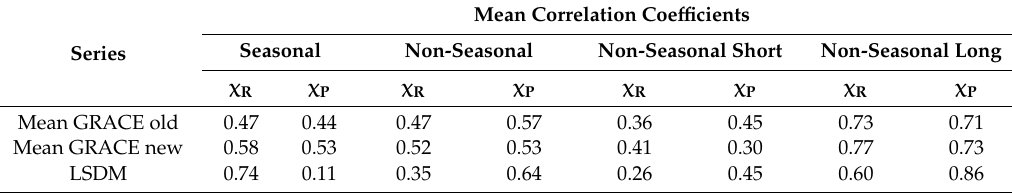
Table 5. Mean values of correlation coe ffi cients between GAO and GRACE-based HAM for each oscillation considered: mean GRACE old (the mean of correlations for CSR RL05, JPL RL05, GFZ RL05, CNES / GRGS RL03, and ITSG-Grace2016) and mean GRACE new (the mean of correlations for CSR RL06, JPL RL06, GFZ RL06, CNES / GRGS RL04, and ITSG-Grace2018). Correlation coe ffi cients for HAM from the LSDM were added for